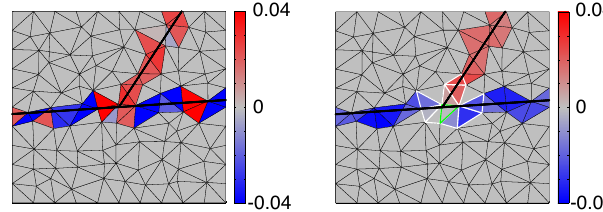
Figure 3. Example of the unfiltered (left panel) and filtered (right panel) divergence obtained for the double-crack test case at a nor- malized resolution of 0.1. The domain is divided into three blocks. Points below the principal crack are fixed. Points above the princi- pal crack experience the same displacement u n , perpendicular to the principal crack (here u n = − 0 . 0025) but have distinct tangent com- ponents: u p for the block on the left (here u p = 0 . 01) and u (cid:48) p for the block on the right of the secondary crack (here u (cid:48) p = 0 . 0125). Triangles in white show the kernel defined for the triangle in green. In this example, the parameter n is equal to